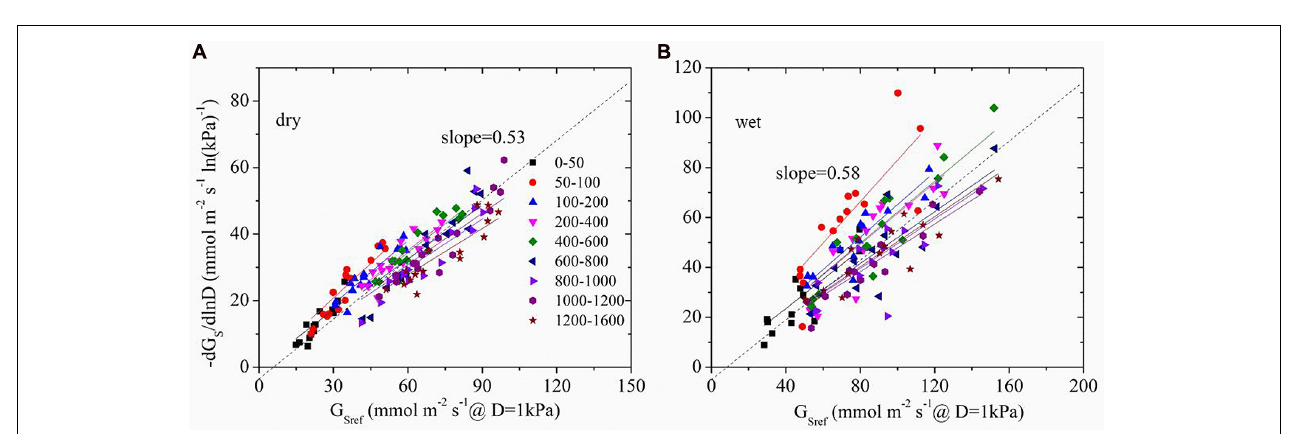
FIGURE 3 | The leaf water potential at (A) pre-dawn ( (cid:57) pre - dawn ) and (B) noon ( (cid:57) noon ) along the tree size gradient in dry and wet seasons.